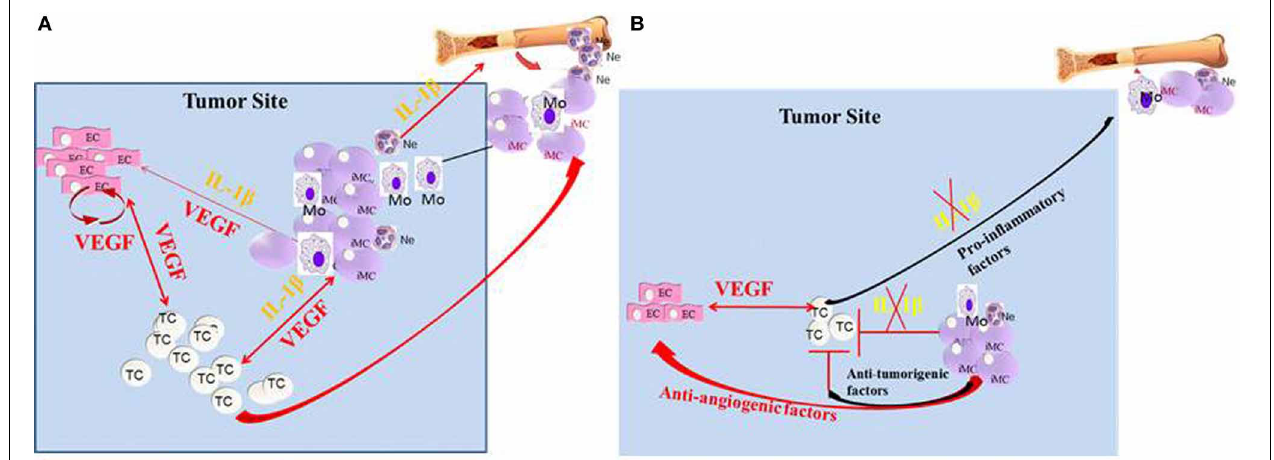
FIGURE 1 | Crosstalk between IL-1 β and VEGF in the tumor microenvironment. (A) In the tumor microenvironment, IL-1 β can be expressed initially by the malignant cells. In turn, IL-1 β can recruit myeloid cells from the BM and further activate them to secrete pro-inflammatory and pro-angiogenic molecules, such as VEGF and IL-1 β . Furthermore, IL-1 β keeps myeloid cells in their immature stage, where they are pro-invasive and immunosuppressive. IL-1 β can also activate tissue-resident ECs to produce